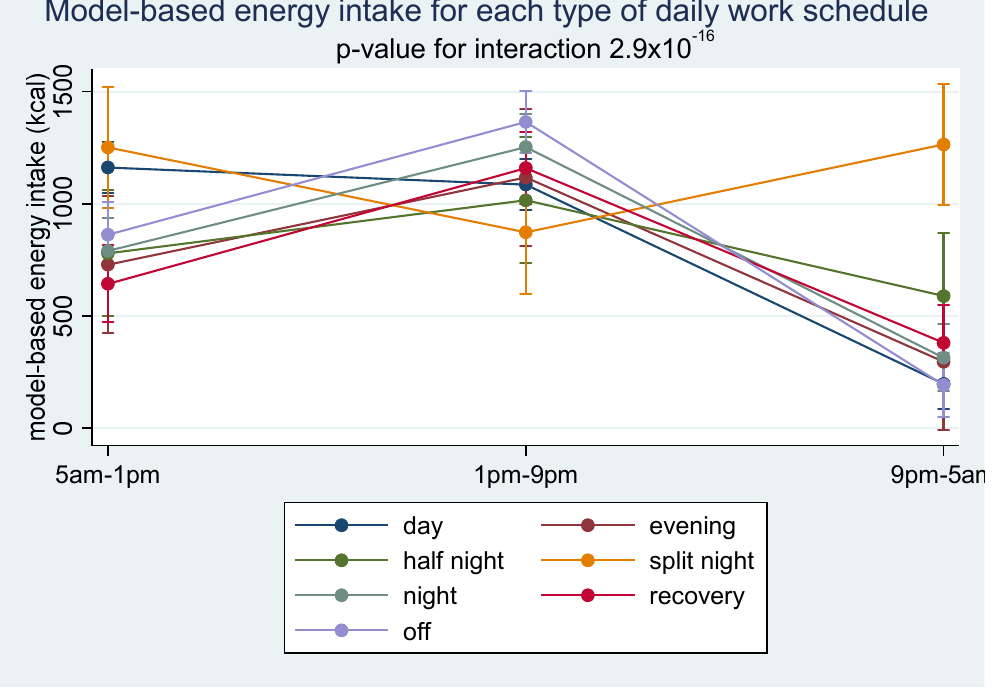
Figure 1. Model-predicted mean energy intake (kcal) with 95% confidence intervals, by 8-h periods according to each schedule type.